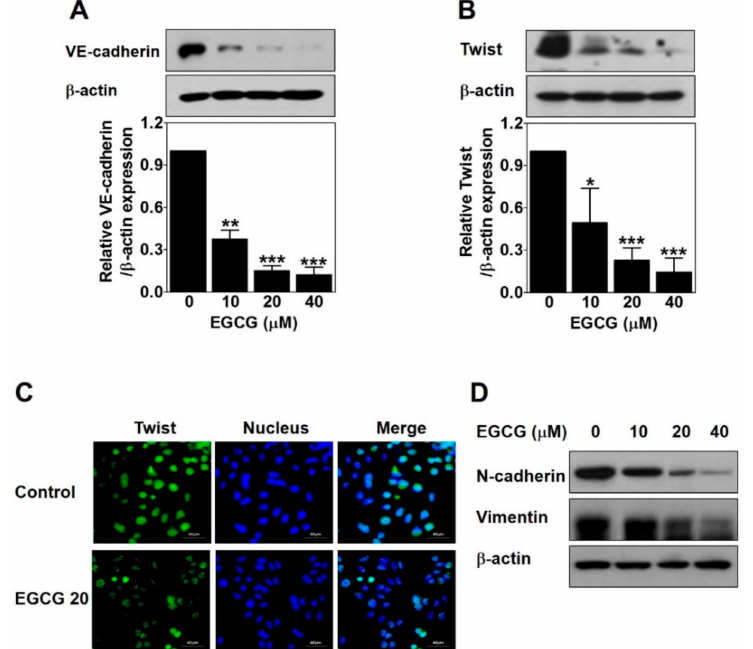
Figure 4. EGCG downregulates vascular endothelial cadherin (VE-cadherin) expression through inhibiting nuclear twist in PC-3 cells. Cells were treated with various concentrations of EGCG (10, 20, and 40 µ M) for 24 h. ( A , B ) Total protein lysates (20 µ g) analyzed by Western blot using specific antibodies. β -actin was used as a loading control. Data are expressed as means ± SD. Results were statistically calculated by Student’s t -test. * p < 0.05, ** p < 0.01, and *** p < 0.001 vs. untreated control. ( C ) The cells treated with or without 20 µ M EGCG for 24 h were incubated with twist antibody, followed by Fluorescein isothiocyanate (FITC) conjugate secondary antibody. After counterstaining with 4 (cid:48) ,6-diamidino-2-phenylindole (DAPI, nucleus), images were photographed at 600 × magnification. Scale bar = 40 µ m. ( D ) Total protein lysates (20 µ g) analyzed by Western blot using specific antibodies. β -actin was used as a loading